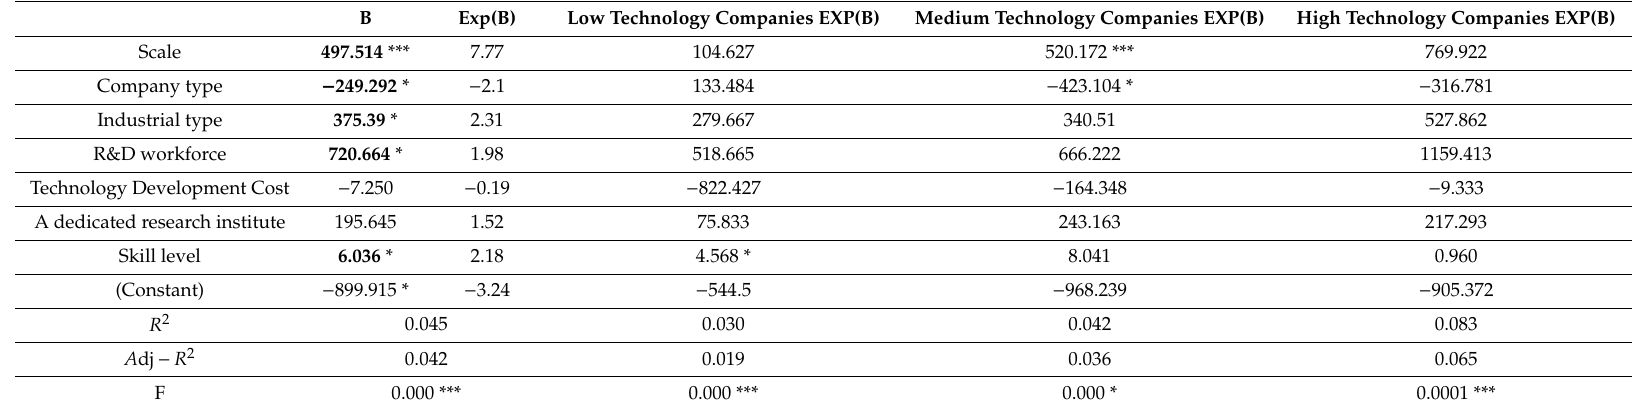
Table 7. Regression analysis result on exports of technology